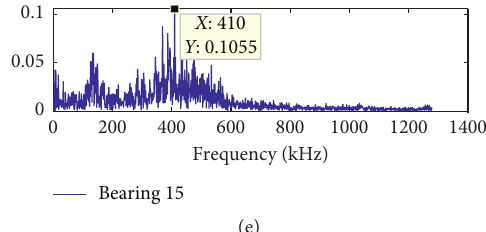
Figure 7: The frequency-domain signal through FFTfor bearings 11–bearing 15. (a) Bearing 11. (b) Bearing 12. (c) Bearing 13. (d) Bearing 14. (e) Bearing